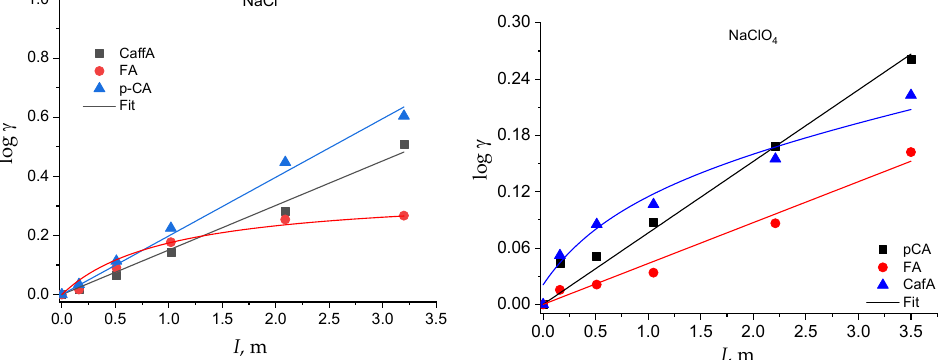
Figure 5. log γ of the hydroxycinnamic acids as a function of the solvent salt and of the ionic strength.